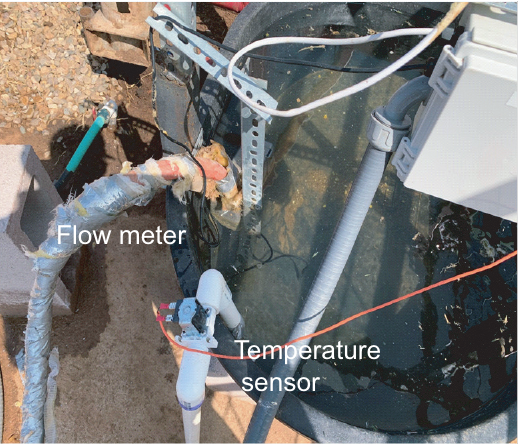
Figure 9. The flow meter and temperature sensor deployed in the trough.